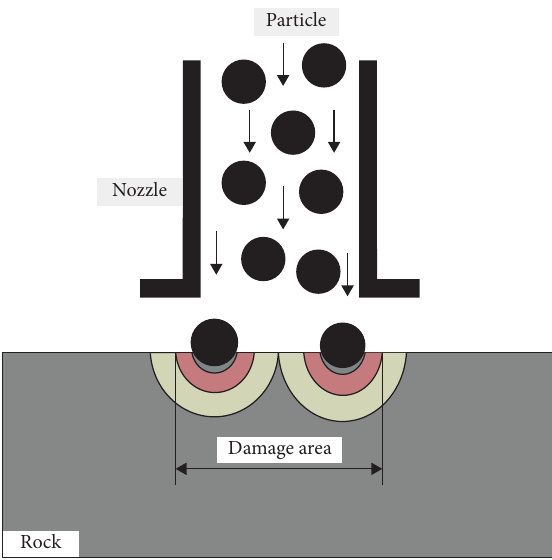
Figure 5: The damage area under multiparticles jet